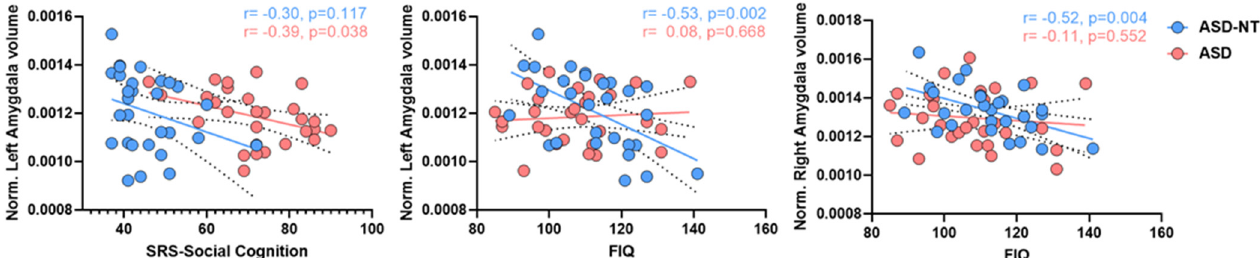
Figure 3. Correlation plots in ASD. ( Left ): correlation between normalized left amygdala volume and SRS-social cognition score in ASD ( r = − 0.39, p = 0.038) and ASD-NT ( r = − 0.30, p = 0.117). ( Middle ): correlation between normalized left amygdala volume and FIQ score in ASD ( r = 0.08, p = 0.668) and ASD-NT ( r = − 0.53, p = 0.002). ( Right ): correlation between normalized right amygdala volume and FIQ score in ASD ( r = − 0.11, p = 0.552) and ASD-NT ( r = − 0.52, p = 0.004). Solid-lines: regression-line (red = ASD, blue = ASD-NT); dashed-lines indicate the 95% confidence intervals for respective regression lines. Table 4. Correlations between subcortical volumes and behavior in ASD and ASD-NT. Correlation ASD ASD-TD Left Amygdala vs. FIQ Right Amygdala vs. FIQ